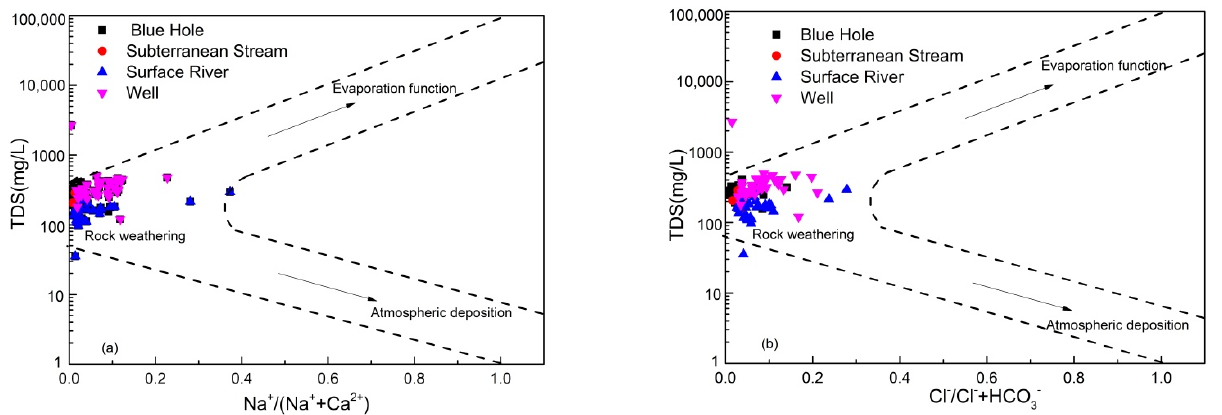
Figure 6. Gibbs diagram representing hydrochemical characteristics of subterranean streams, blue holes, wells, and surface rivers of the Huixian karst wetland.